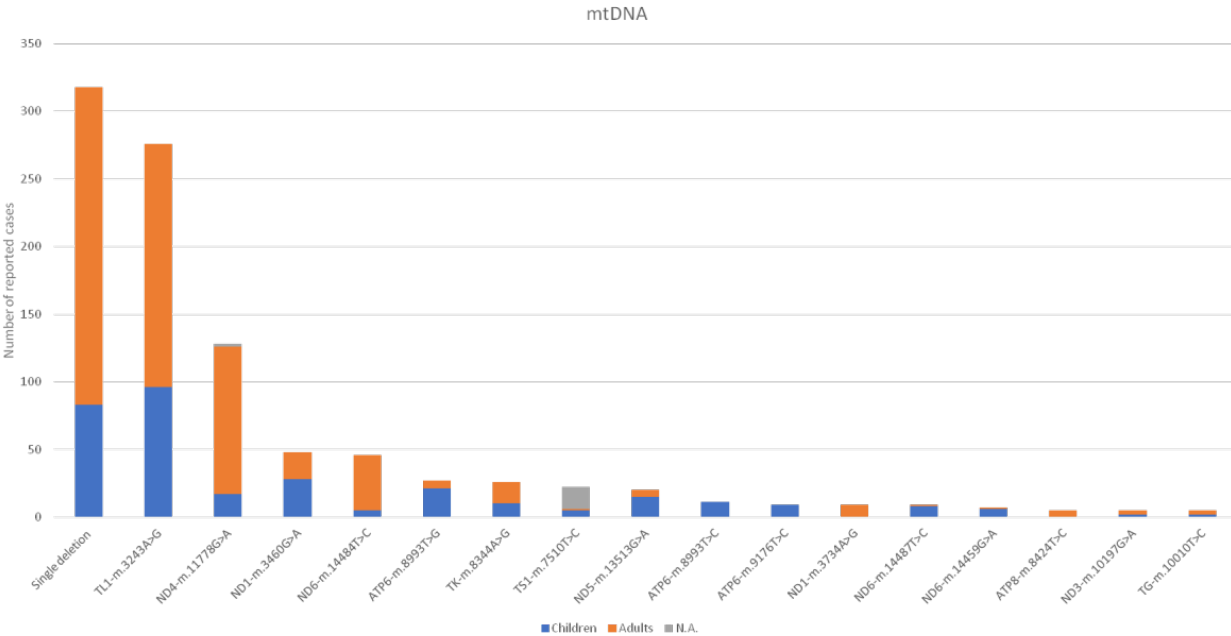
Figure 2. Number of reported cases for nDNA mutations distributed by age. Only genes with more than four cases are depicted. The rest of mutated genes and number of patients reported are detailed in Supplementary Table S2. Abbreviations: N.A., not available.